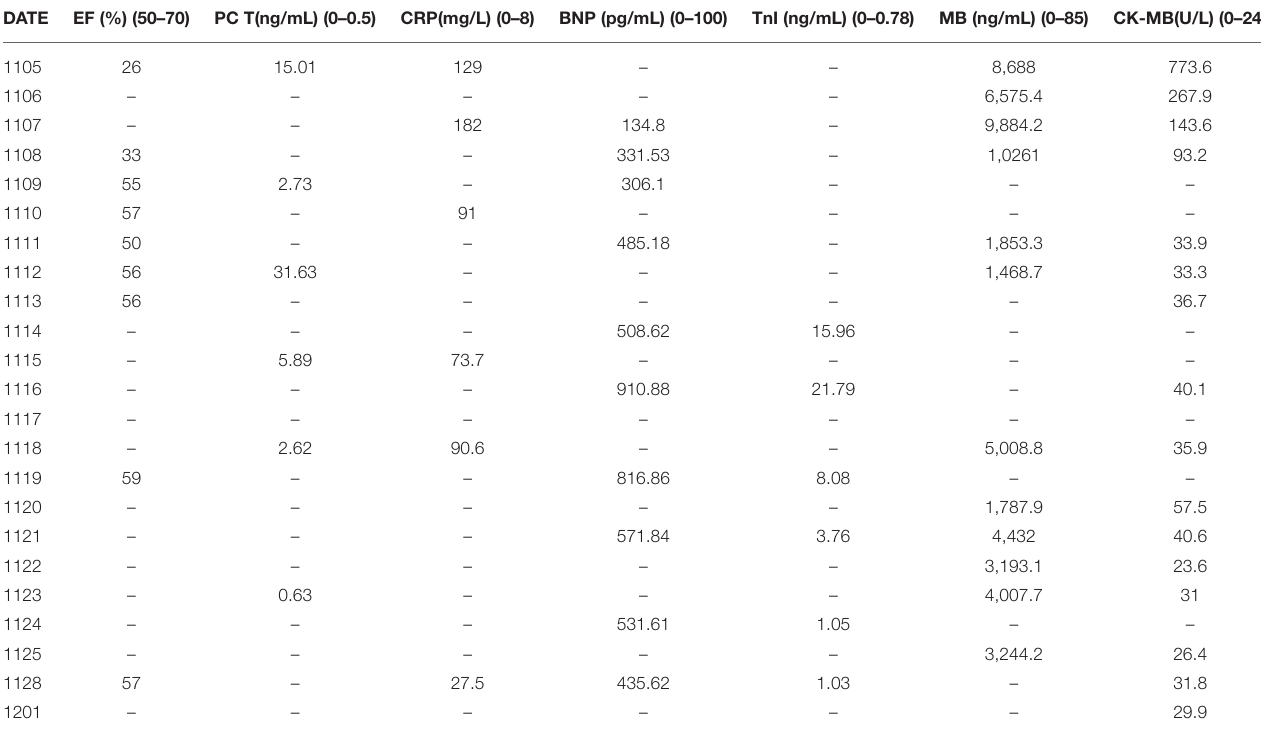
TABLE 1 | Timeline with the tests and